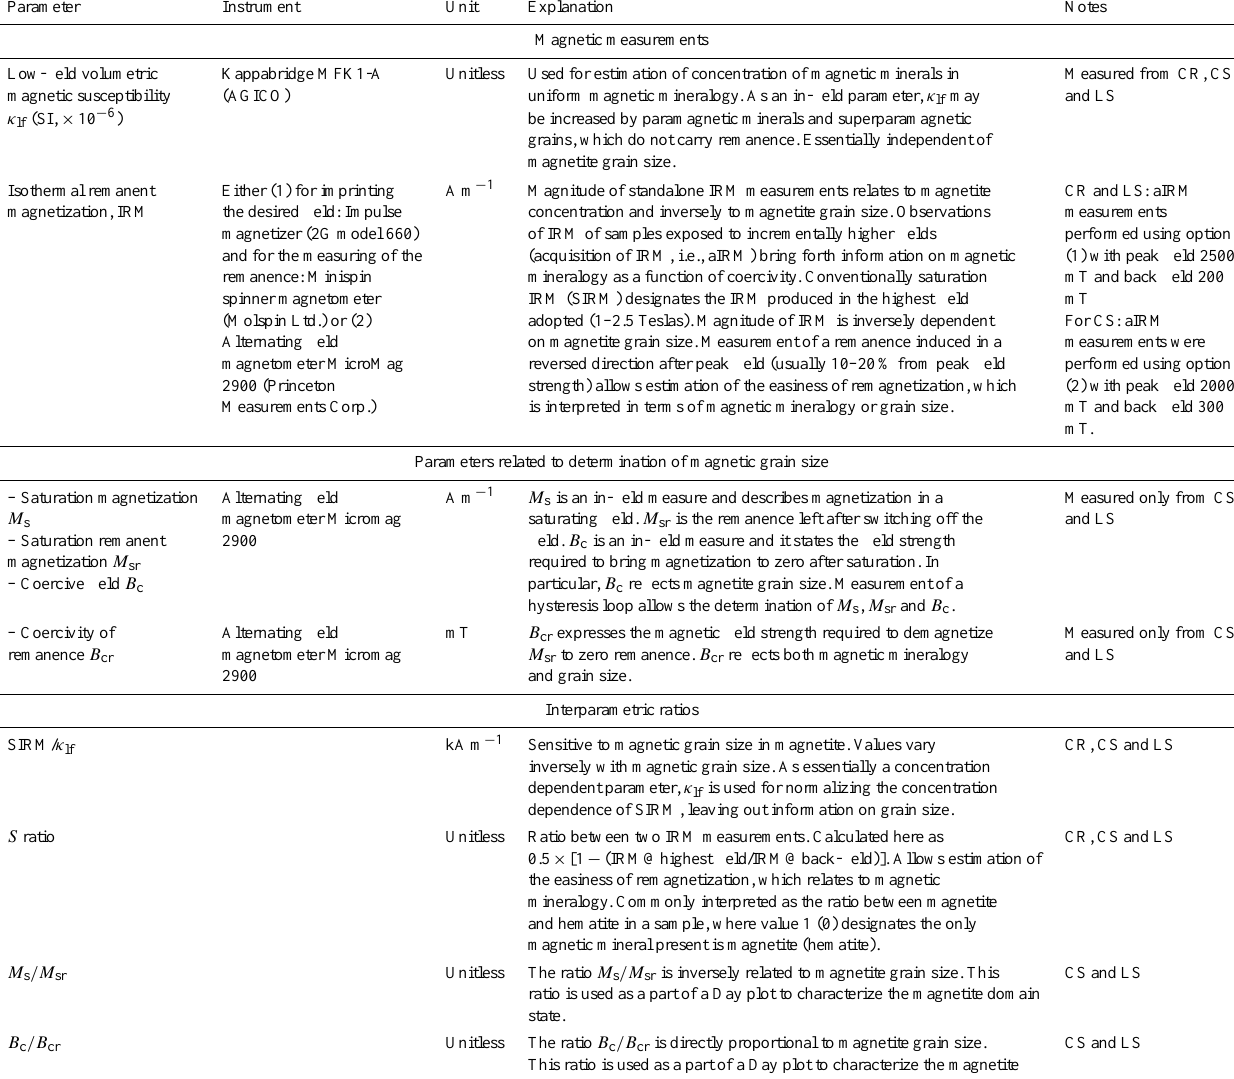
Table 2. Information on magnetic parameters used to characterize mineral magnetic assemblages in catchment rocks, creek sediments and lake sediments from Lake El’gygytgyn and its catchment. CR=catchment rocks, CS=creek sediments and LS=lake